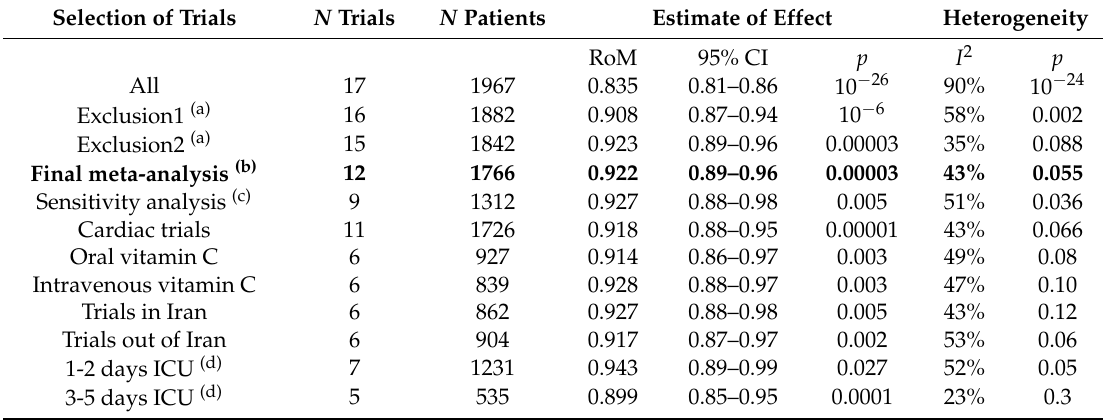
Table 2. Meta-analyses of all included trials and selected subgroups on the length of ICU stay. Selection of Trials N